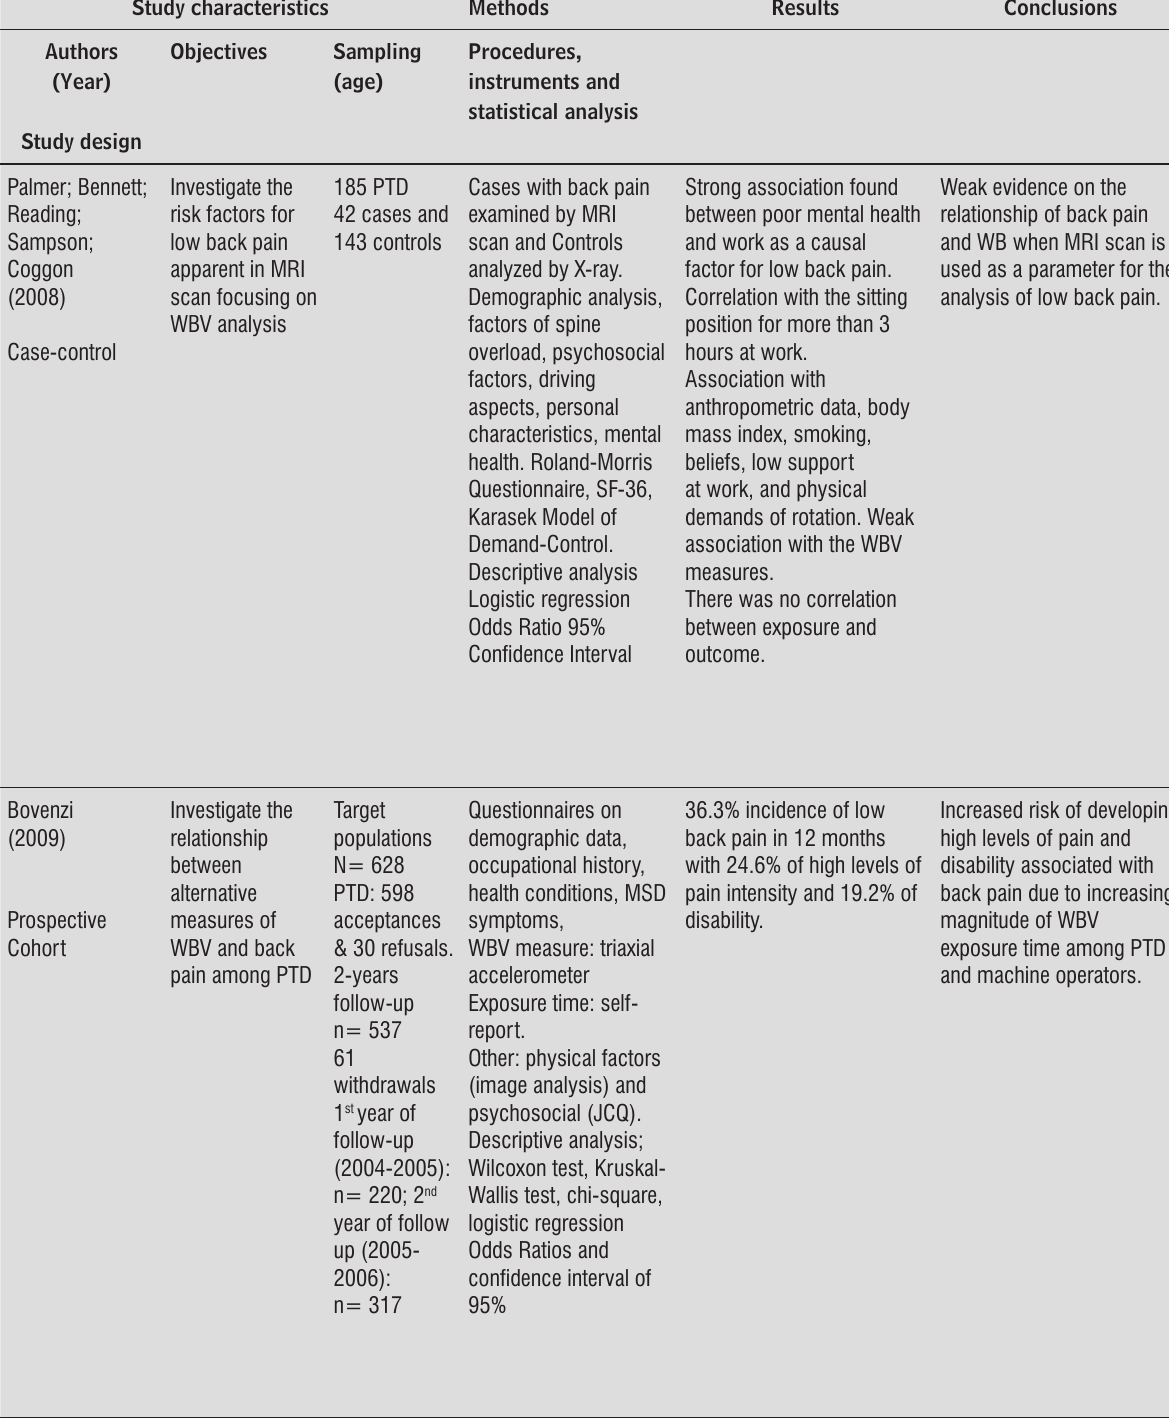
Table 3 - Characteristics of the articles selected for systematic